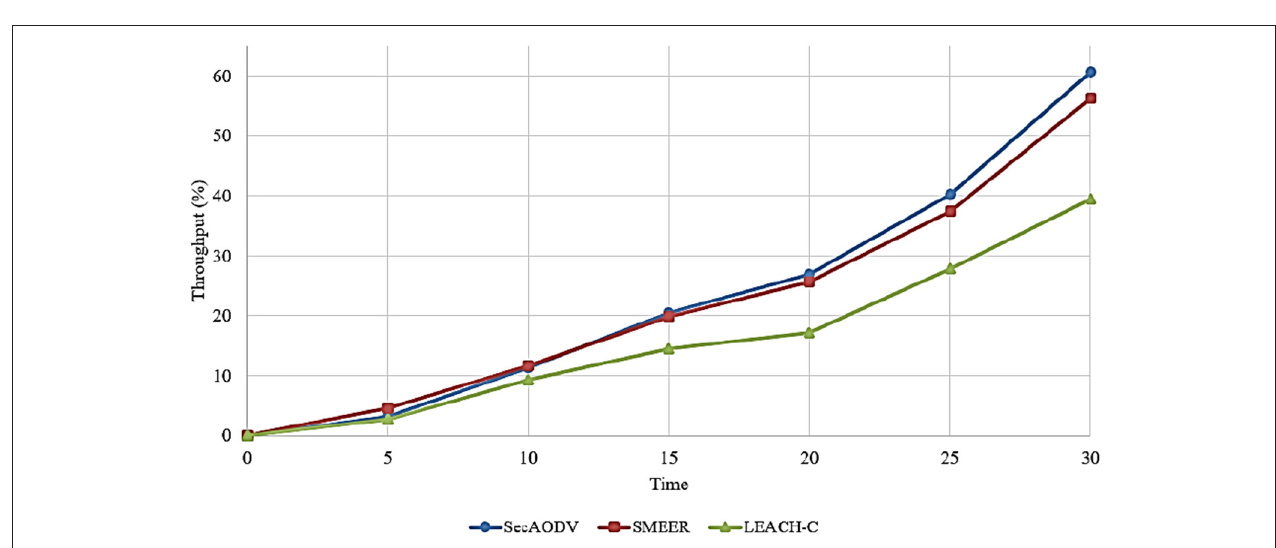
FIGURE 8 | Comparison of different methods in terms of